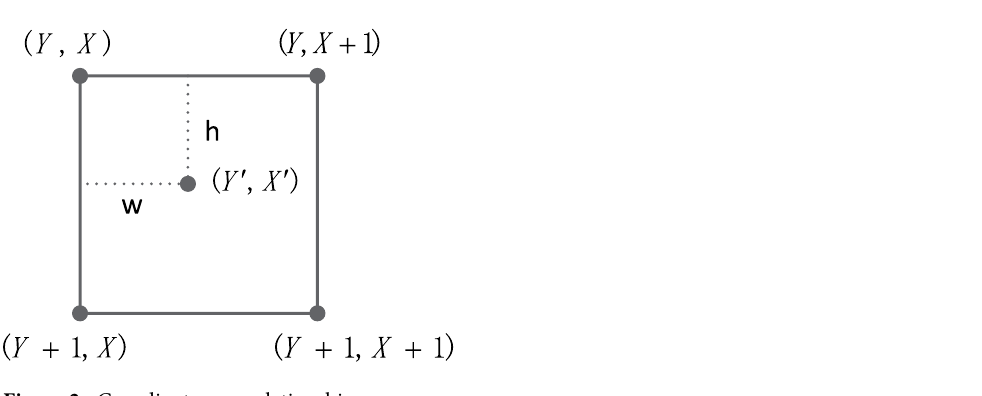
Figure 2. Coordinate map